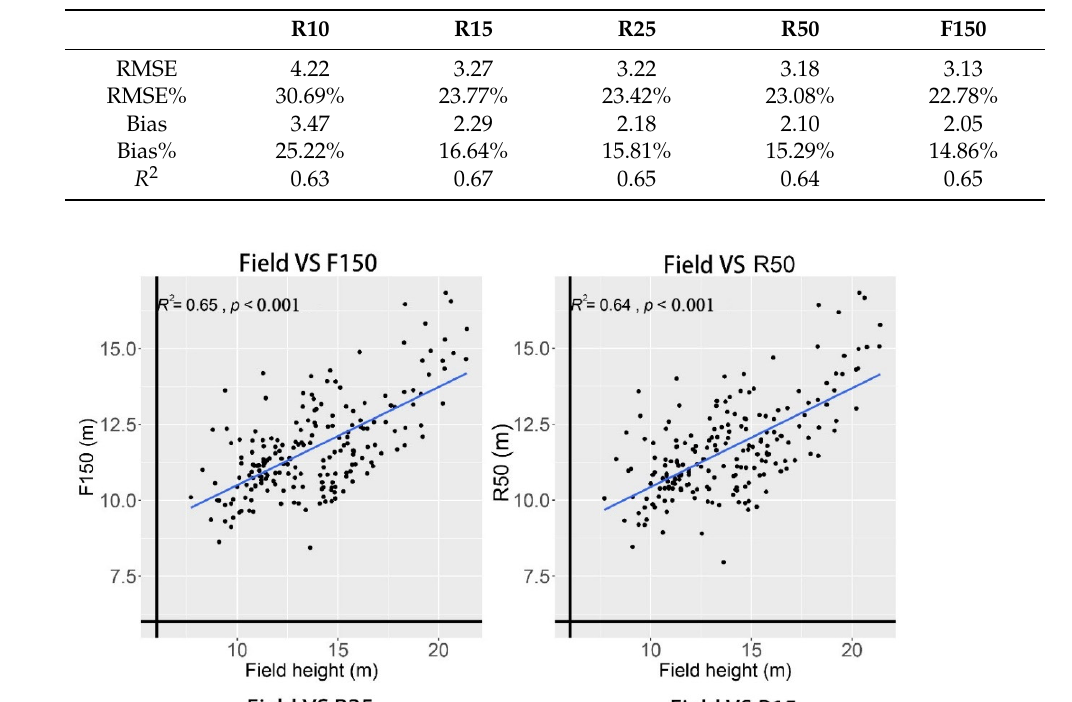
Table 3. Extraction accuracy of D. pierrei height under different point cloud densities.